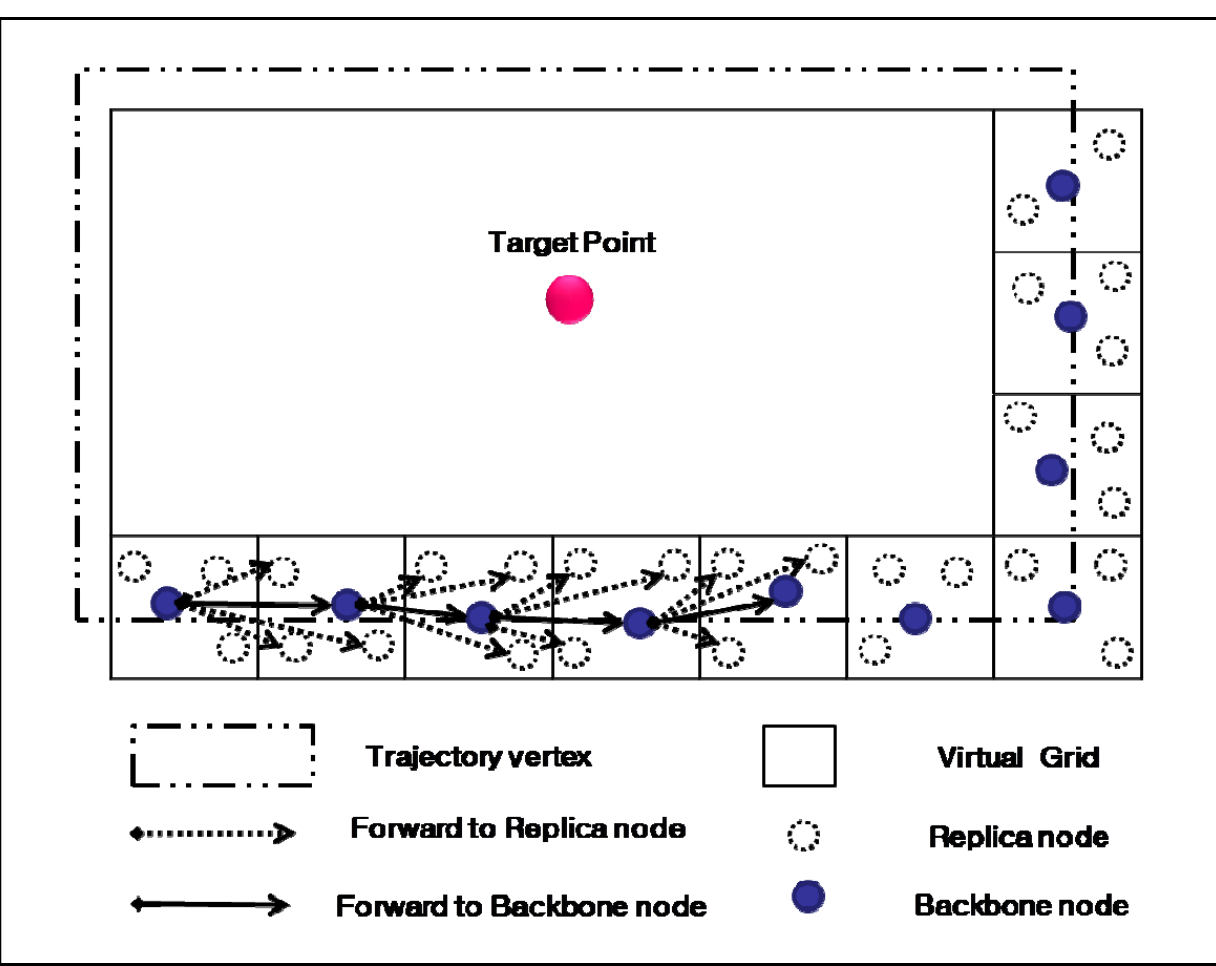
Figure 5. Trajectory